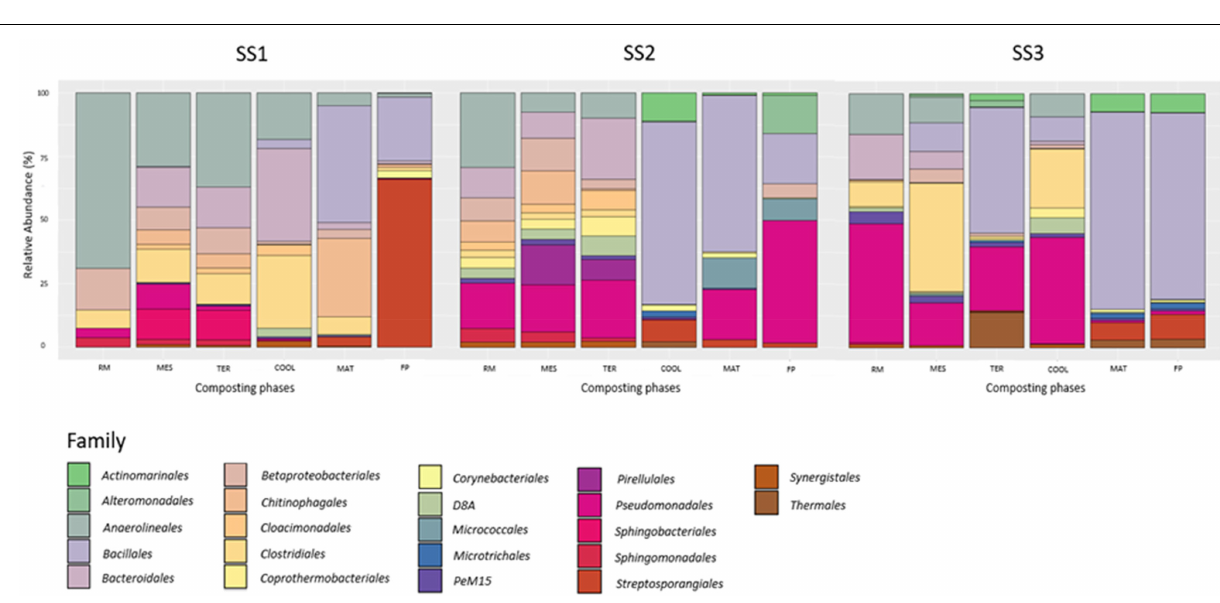
FIGURE 3 | Relative abundance of bacterial families in compost samples from sludge sewage industrial-scale composting facilities. Raw material (RM), mesophilic phase (MES), thermophilic phase (TER), cooling phase (COOL), maturation (MAT), and final product (FP). The figure represents the percentage of presence of each bacterial family in the three sampled composting plants. SS1, SS2, and SS3 represent each of the sampled sewage sludge composting